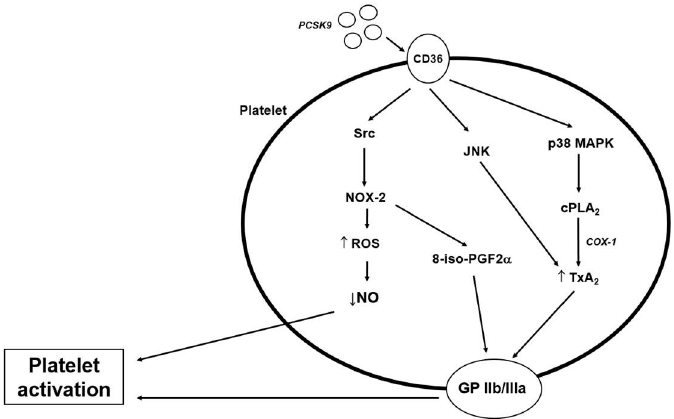
Figure 2. Possible effects of PCKS9 on platelets and signalling pathways that enhance platelet acti-